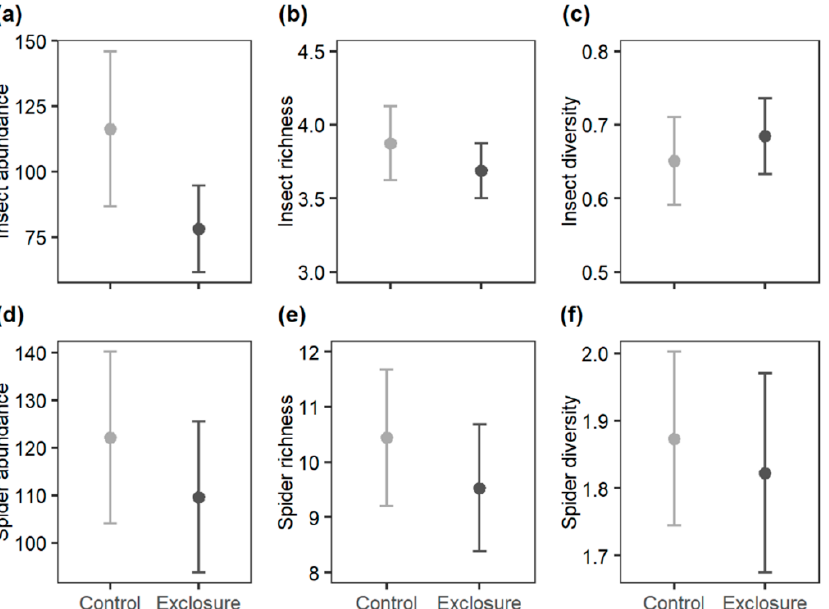
Figure 3. Shows mean (±SE) abundance, richness, and diversity of herbivorous insects ( a – c ) and spiders ( d – f ) in control (light grey) and exclosure plots (dark grey). We found no statistical differences at the α < 0.05 level among the depicted parameters.